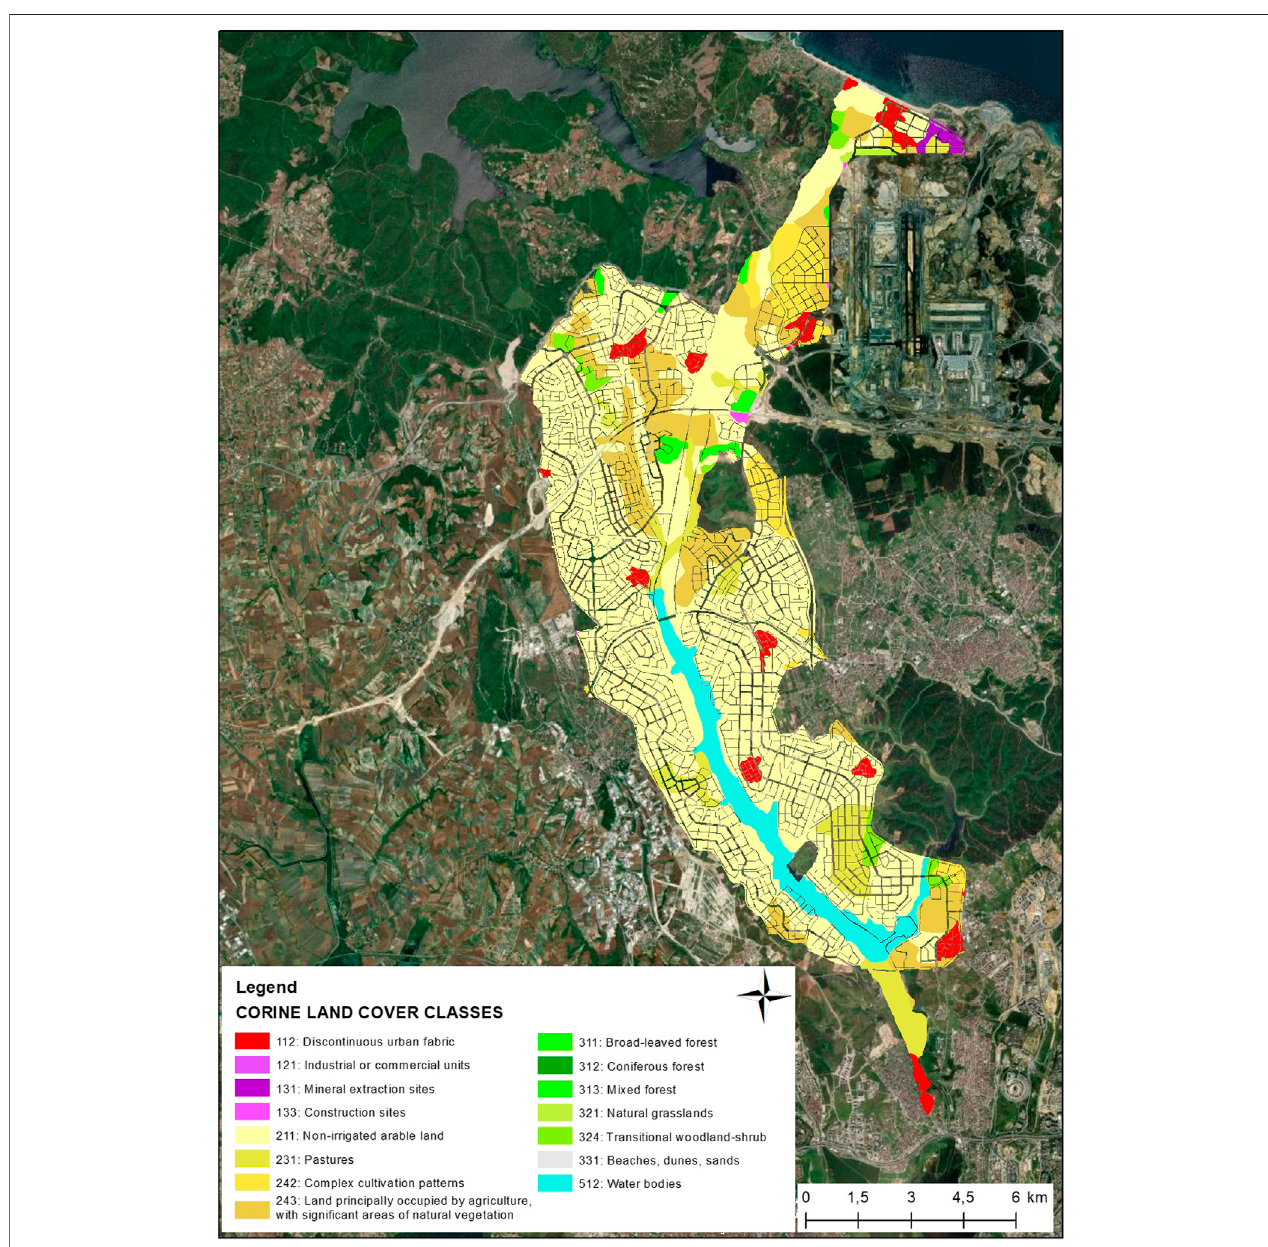
FIGURE 6 | Land cover of Canal Istanbul ’ s